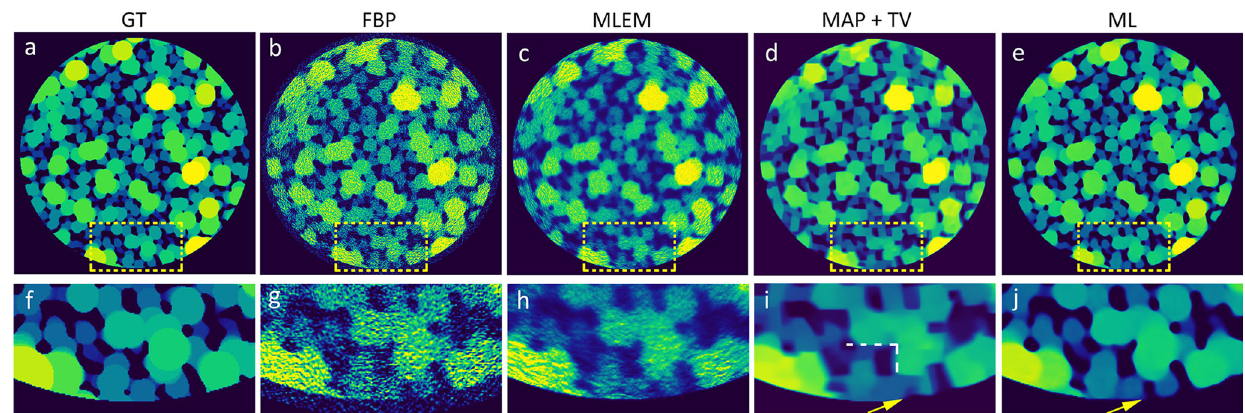
Fig. 3 Evaluation of different reconstruction methods. a Ground truth. b Reconstruction using FBP, with PSNR = 11.69 and SSIM = 0.38. c Reconstruction using MLEM, with PSNR = 17.77 and SSIM = 0.60. d Reconstruction using TV regularized MAP, with PSNR = 21.70 and SSIM = 0.77. e Reconstruction using machine learning (ML) method, with PSNR = 25.02 and SSIM = 0.88. Enlarged views inside the dashed square are shown in ( f – j ), respectively. Note: the dashed lines in ( i ) illustrate the straight boundary of the original curved particle reconstructed using the MAP + TV method. The arrows in ( i ) and ( j ) compare the reconstruction of a small feature (empty hole) using MAP and ML.